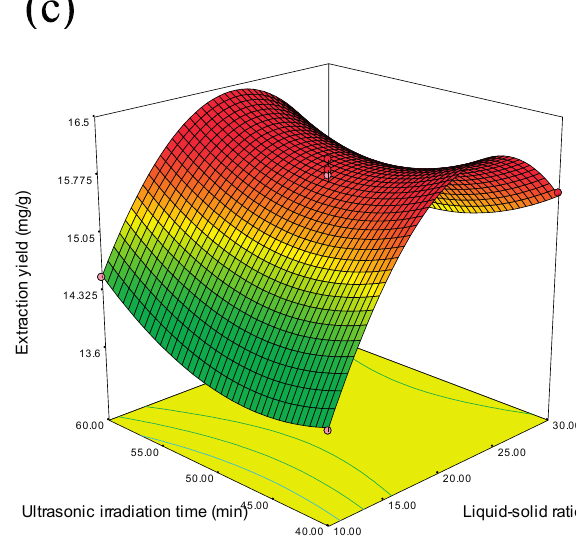
Figure 3. Response surface plots showing the effects of variables on the average extraction yield of SDG: ( a ) interaction of the IL concentration and liquid–solid ratio; ( b ) interaction of the IL concentration and ultrasonic irradiation time; and ( c ) interaction of the liquid–solid ratio and ultrasonic irradiation time.